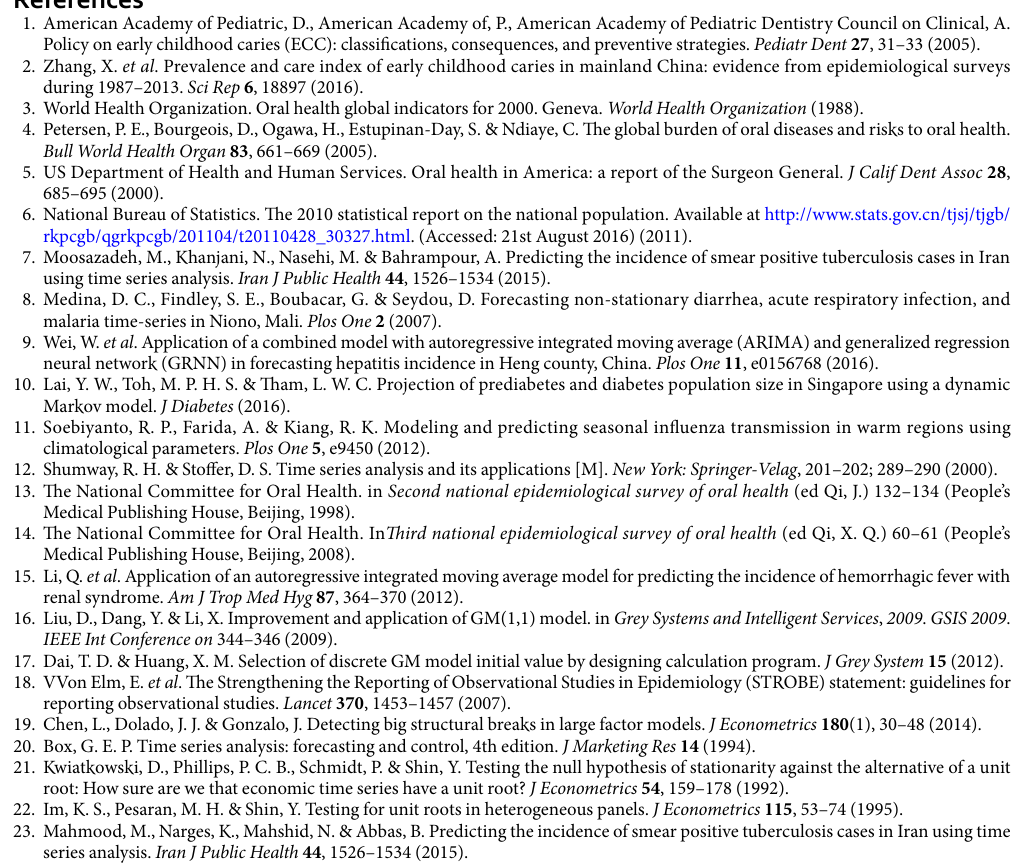
accuracy 34, 35 . Finally, whether this new prediction method is suitable for other epidemic diseases needs further validation. In general, the oral health status of children in China has improved over time. We have developed a new pre- diction method based on data from meta-analyses. Both ARIMA model and GM can be used in fitting and fore- casting the prevalence of ECC in mainland China. More precise prediction models may be needed to explain the variation of the ECC trend. We aim to promote general awareness in the local Chinese governments to establish the epidemiological database of ECC on a regional level. Then, we can take the economic or population difference